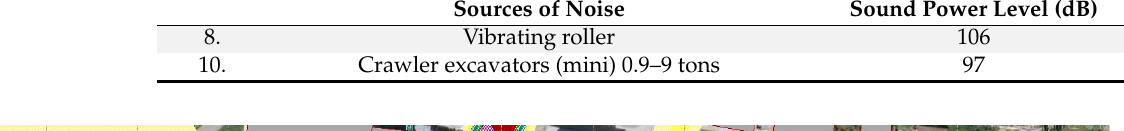
Table 23. Expected sources of construction noise.